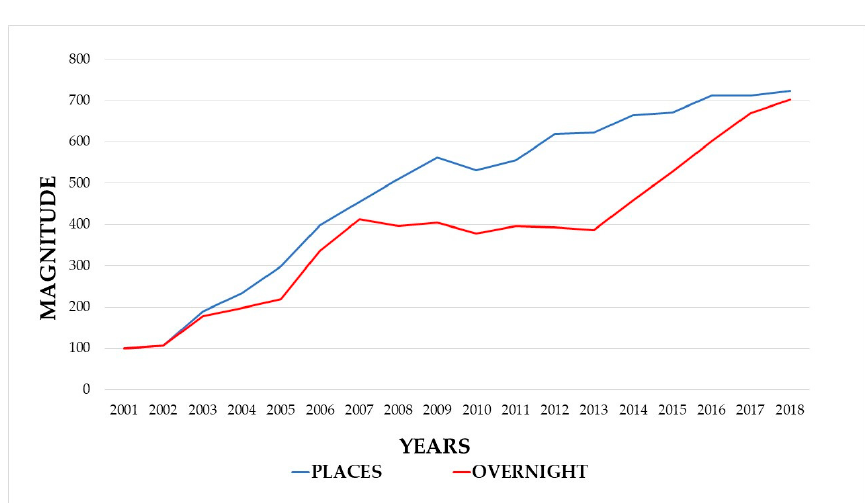
Figure 2. Comparison between beds available and overnight